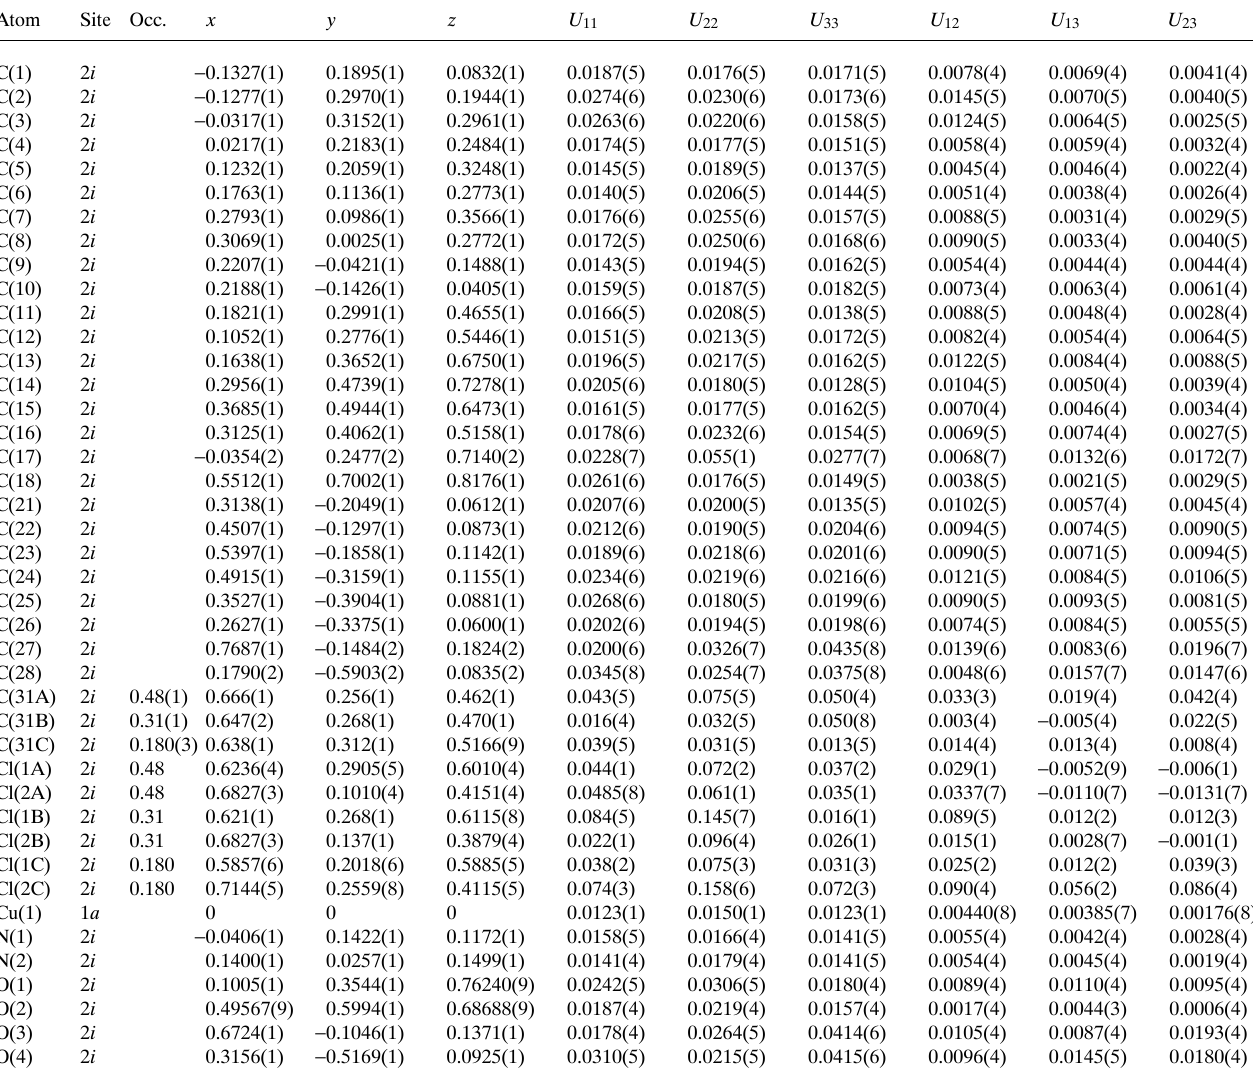
Table 6. A tomic coordin a tes a nd displ a cement p a r a meters (in Å 2 ) .